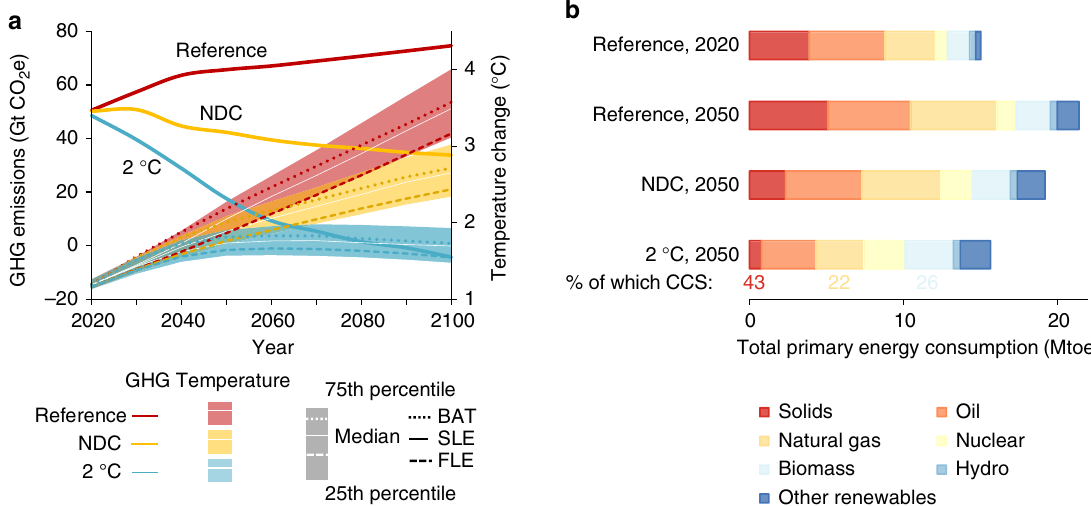
Fig. 1 Climate policy scenarios and corresponding energy systems. The fi gure shows greenhouse gas emissions, global average temperature change compared to pre-industrial levels, and energy consumption by source in the three climate policy scenarios. a Greenhouse gas emissions and median temperature changes over the course of the century. Median temperature changes in the case of Best Available Technologies (BAT) and Fixed Legislation (FLE) air quality scenarios are shown by dotted lines above and below the white line indicating the Stringent Legislation (SLE), respectively. Shaded area indicates 25th and 75th percentiles. b Total primary energy consumption by source. Other renewables include solar, wind, and geothermal energy. The percentage of solids, gas, and biomass energy consumption that uses carbon capture and storage (CCS) is indicated for the 2 °C